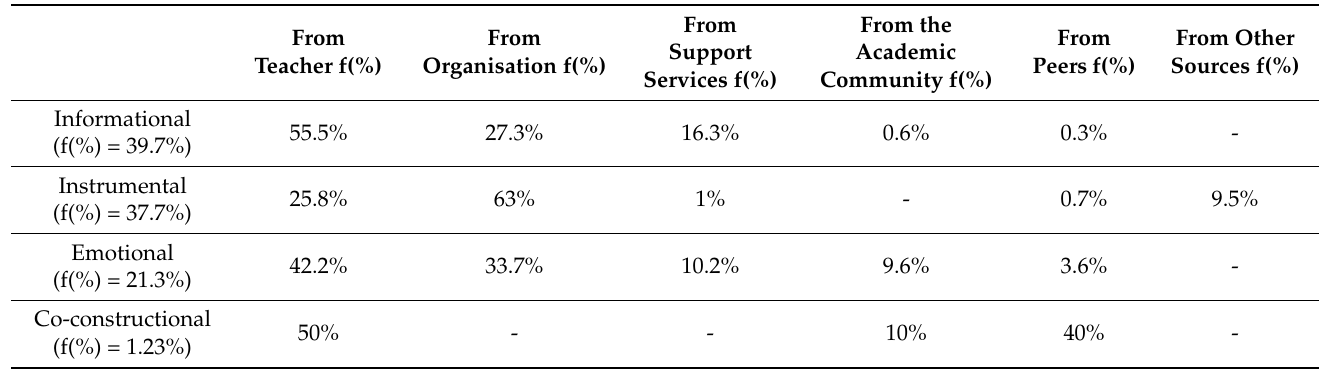
Table 3. The percentages of different sources of support in each support form.